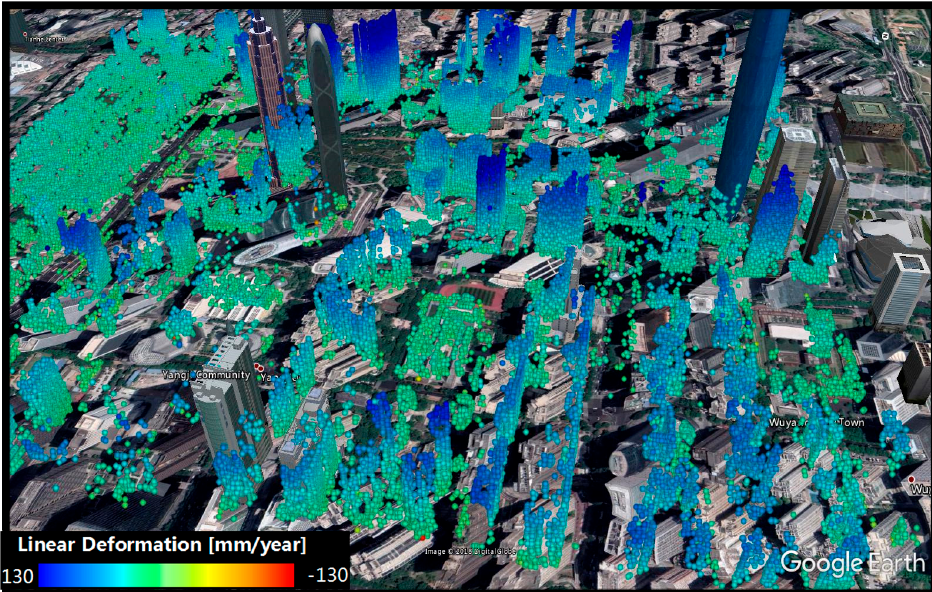
Figure 14. 3D view of the estimated linear deformation trends visualized with Google Earth for the proposed method.